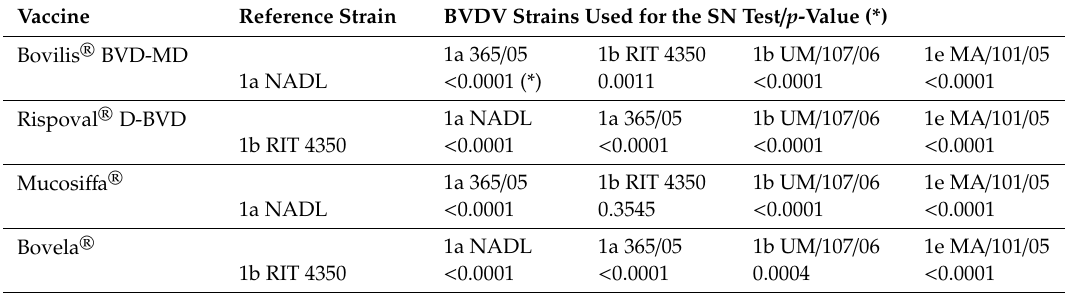
Table 3. Wilcoxon test results ( p -value), through Napierian logarithm, to evaluate the di ff erence between post-vaccination antibody titres against the homologous virus (or the proxy variable) and other selected test viruses; (*) statistical significance p <